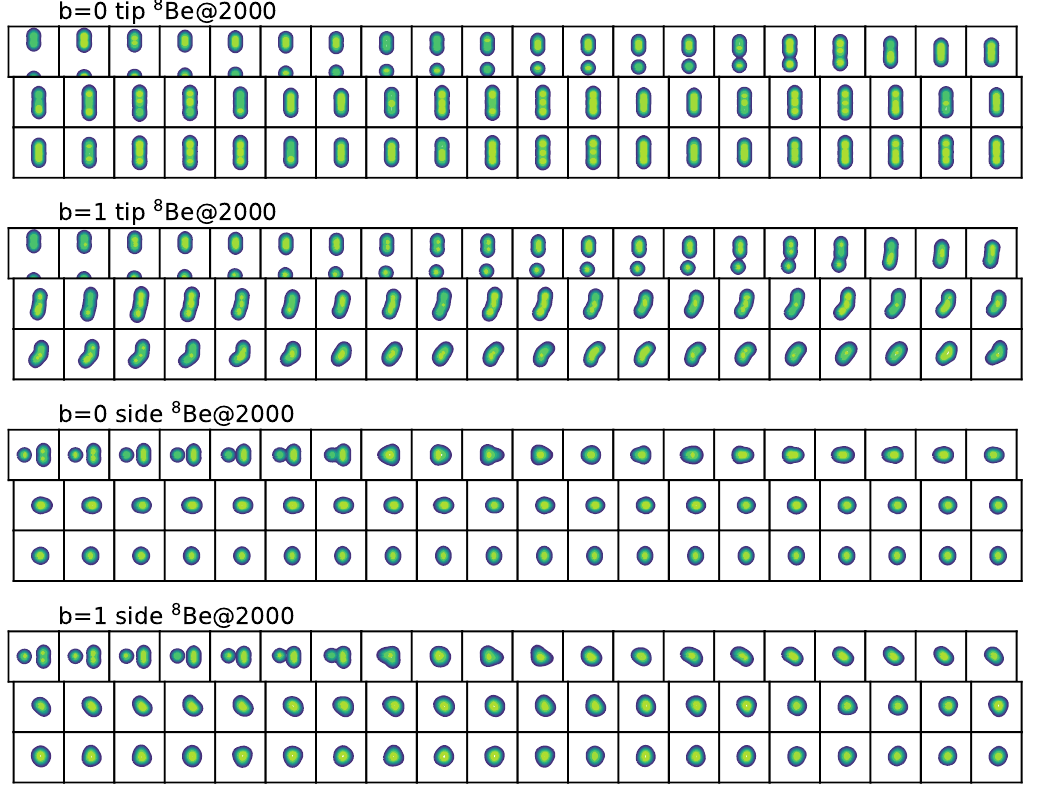
Figure 3: Snapshots of the time evolution of the total density for four of the trajecto- ries shown in Figure 2, as labelled. Snapshots are every 20 fm / c ( (cid:39) 0.067 zs) starting from the top left and reading first left-to right, then top to bottom. The final frames, on the bottom right of each set, are at a time 1220 fm / c ( (cid:39) 4.0